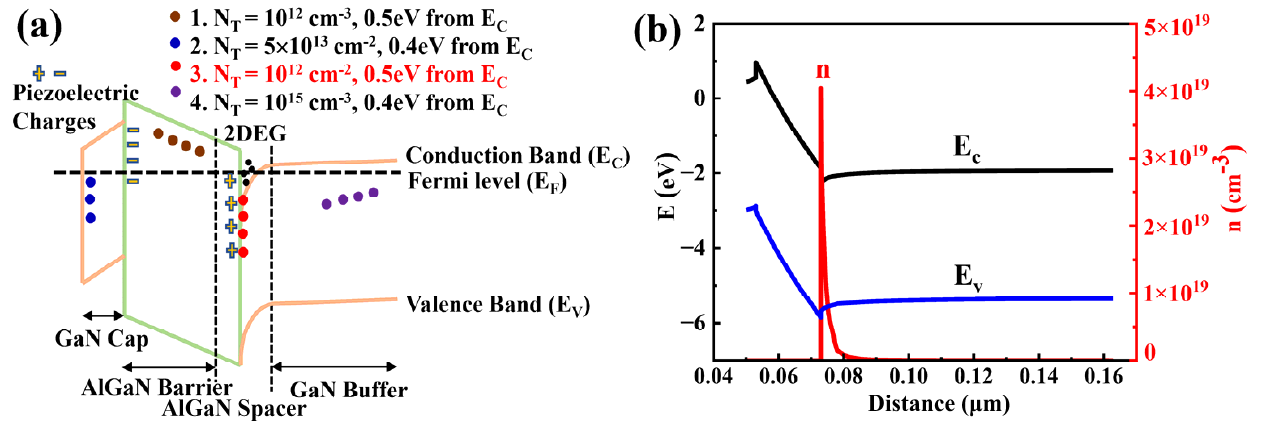
Figure 3. ( a ) Band diagram illustrating simulated trap details. ( b ) Energy band edge (black and blue lines) and electron density (red line) in the vicinity of the channel.